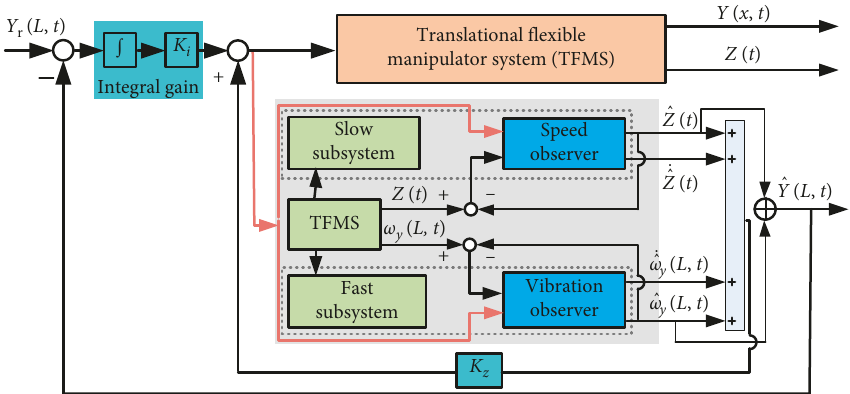
Figure 2: State feedback integral controller of the